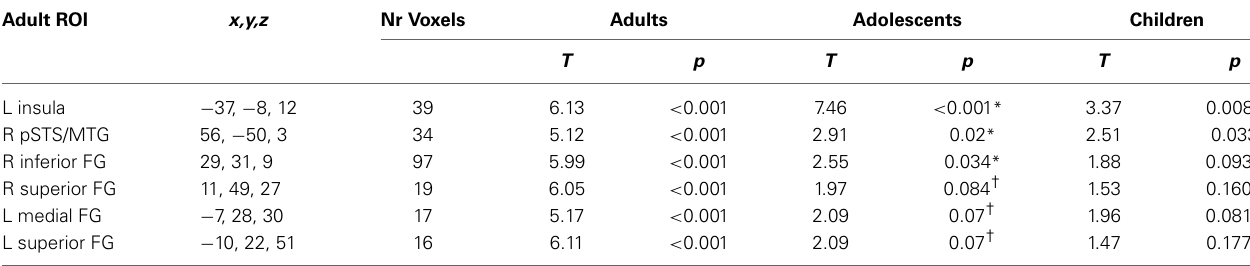
Table 3 | Adult affective-motivational ROIs and activations in response to Arm touch in all age groups. Adult ROI